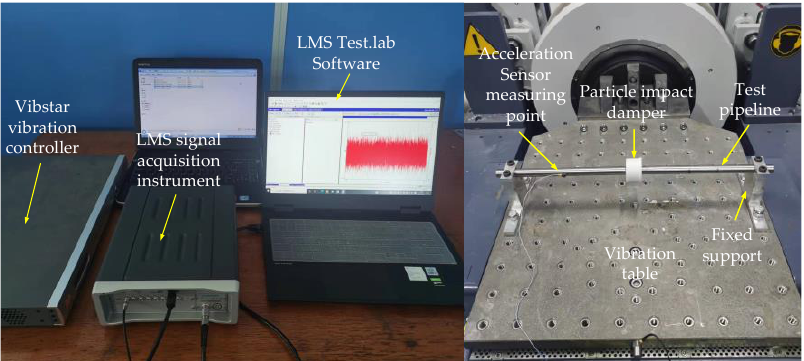
Figure 5. Experimental setup of the vibration test.